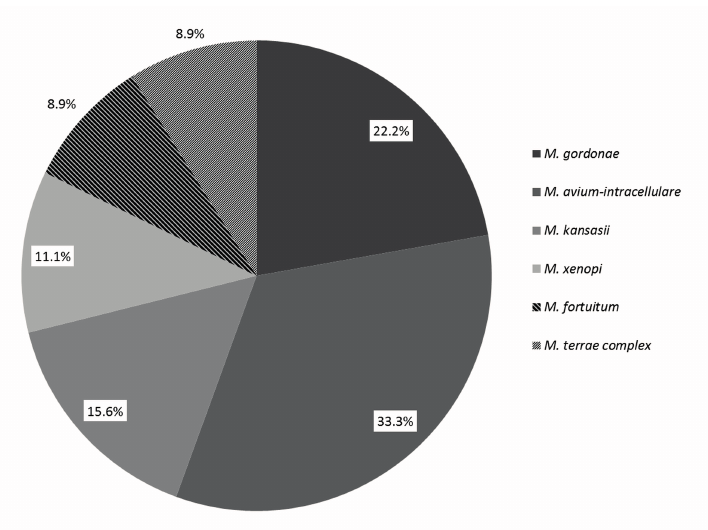
Figure 2. The proportions of environmental mycobacteria detected in treated surface water for the hygiene of employees in large industrial companies and